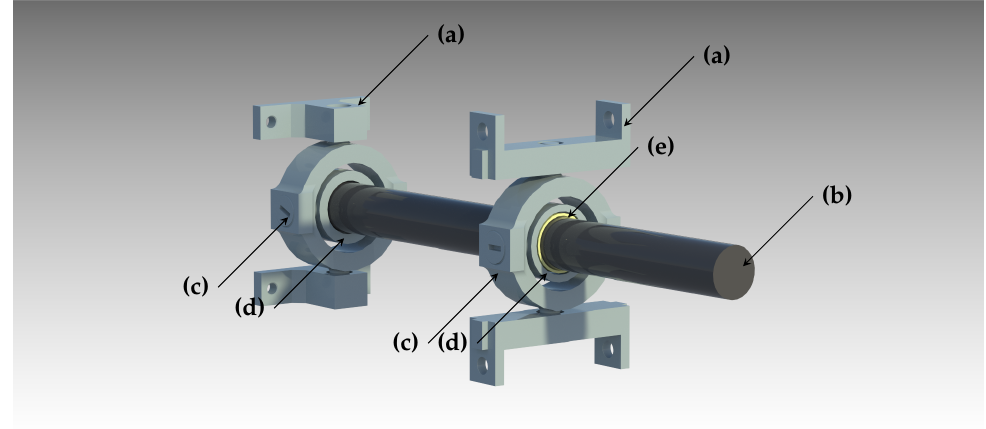
Figure 6. Double-gimbal lever system for converting a translatory motion into a rotary one: ( a ) gimbal mounts; ( b ) central orienting shaft; ( c ) outer segment of universal joint for pan motion; ( d ) inner segment of universal joint for tilt motion; ( e ) circular joint in the form of a linear sliding